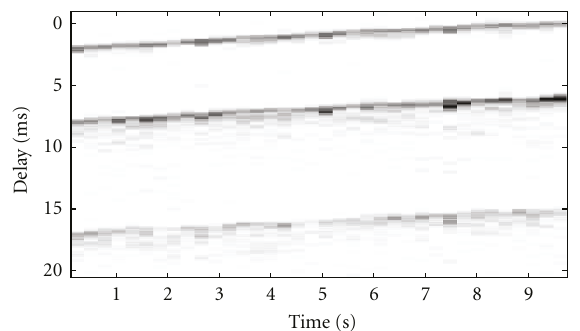
Figure 12: Two-dimensional representation of the underwater acoustic channel estimation over time, zoomed-in around the first three arrival path groups for the KAM08 experiment.